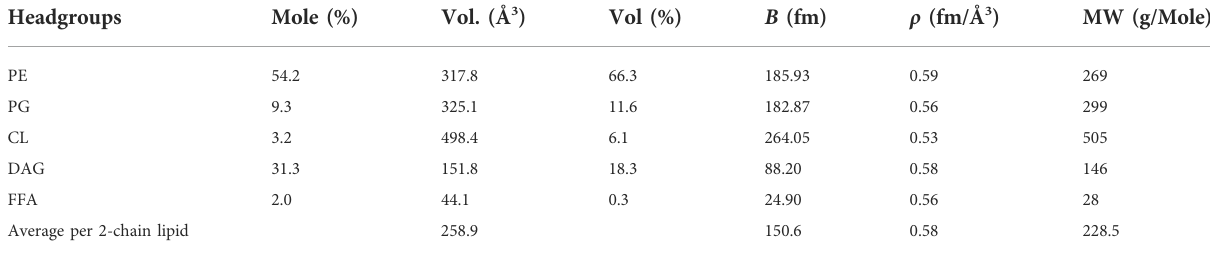
TABLE 3 Input parameters for the headgroup portion of lamellar model (Tan et al., 2021) of cell membrane structure taken from the B. subtilis lipid extract model (Nickels et al., 2017a). This portion of the membrane is contrast matched to 85% D 2 O resuspension buffer, making the resulting fi t insensitivetothispartofthemembranestructurebutifwatercontentequaltotheextractisassumed,n W =11.6,aheadgroupthickness(D H )of11.3± 0.2 Å can be inferred.